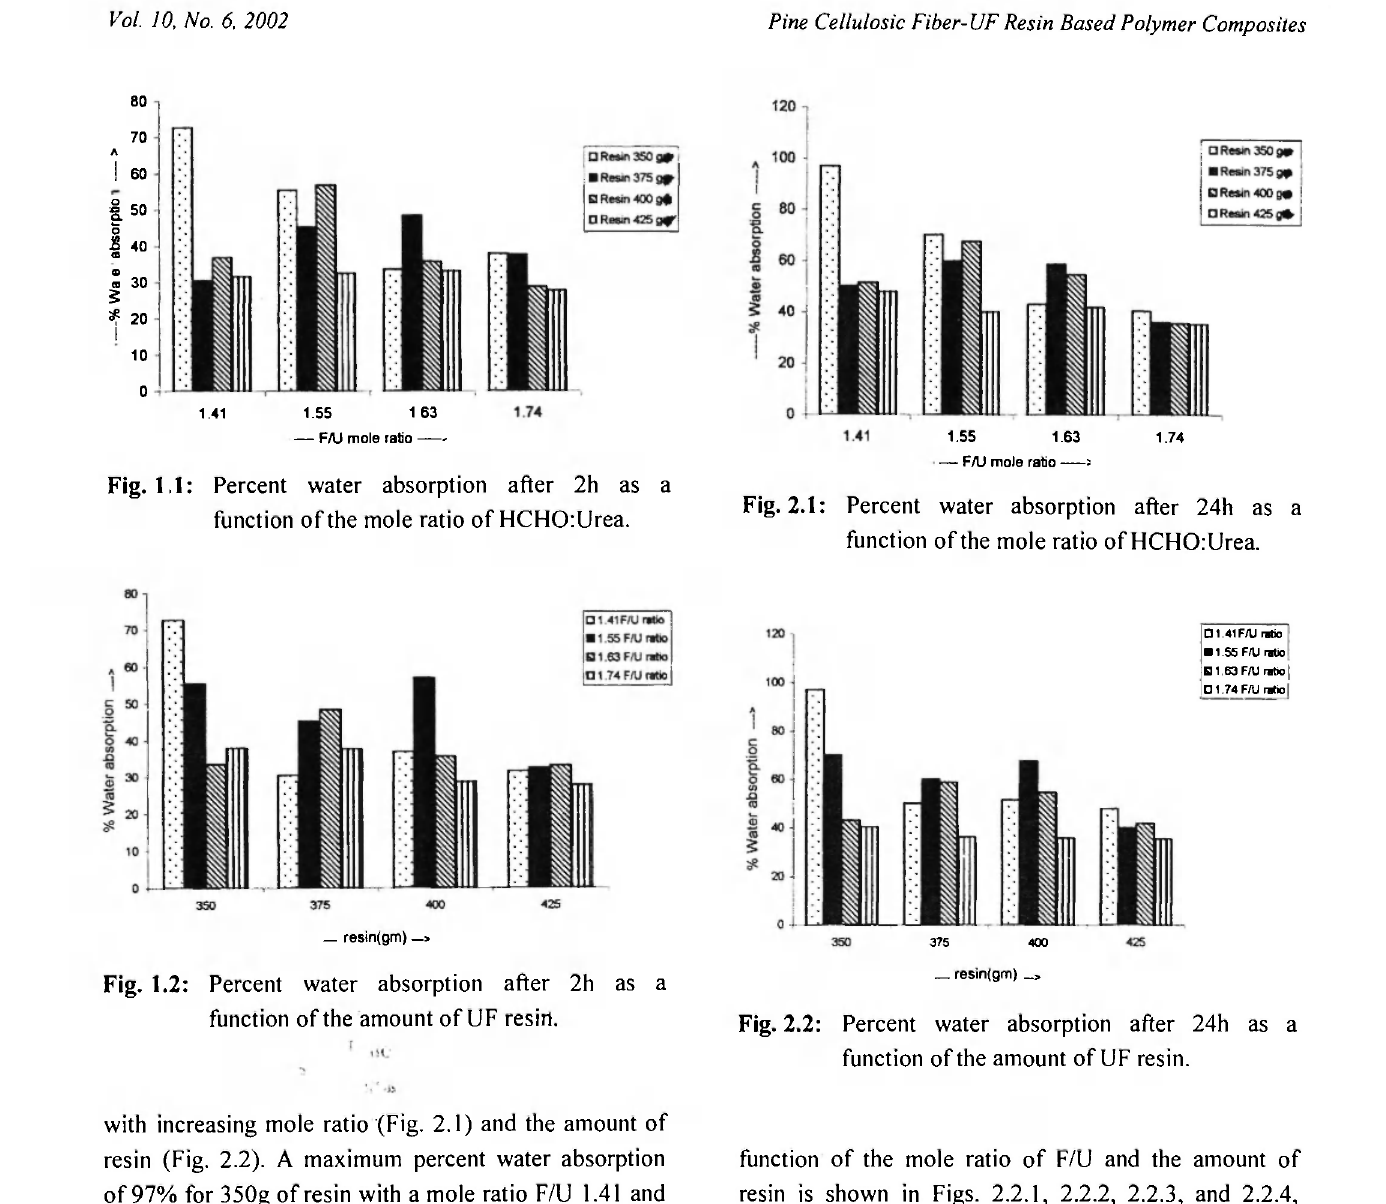
Fig. 1 .2: Percent water absorption after 2h as a function of theamount of UF resirt. Fig. 2.2: Percent water absorption after 24h as a function of the amount of UF